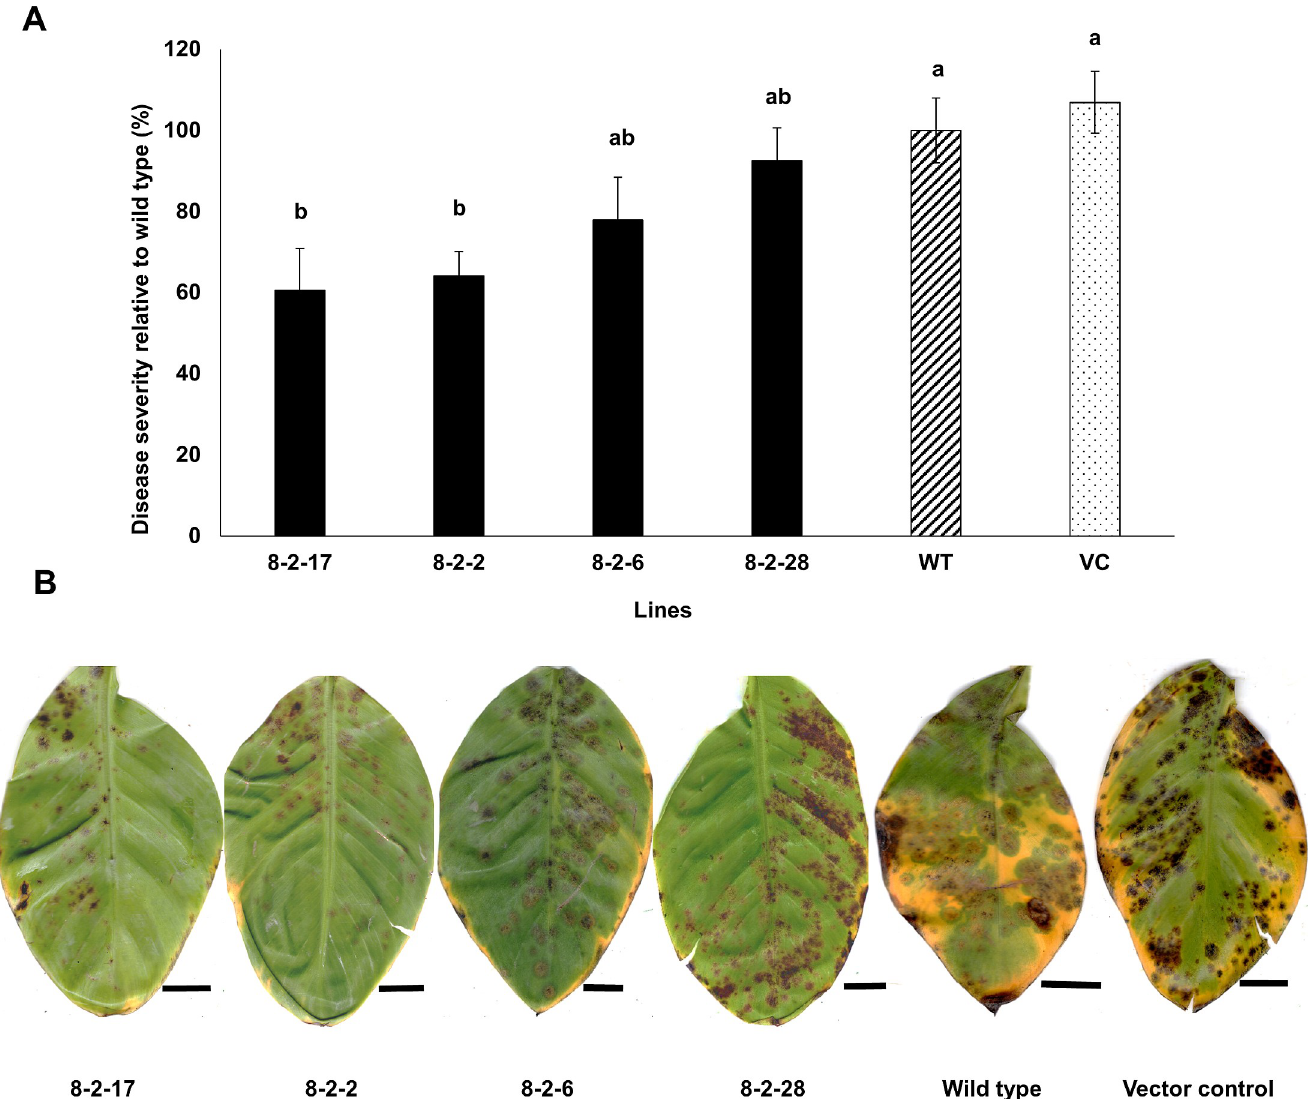
Fig 8. Black Sigatoka disease development in banana inoculated with wild type, vector control, and transformants silenced with the PKS8-2 silencing construct. A) Black Sigatoka disease response as seen in banana plants 9 weeks after inoculation with the wild type (hatched bar), vector control (dotted bar) and silencing transformants (dark bars). Disease severity caused by each isolate was assessed by the Fiji ImageJ program and is shown relative to wild type isolate 10CR1-24. Data shown are results of two independent experiments with 8 plants per strain in each experiment. The within-group differences between the different PKS8-2 silencing transformants, vector control, and wild type isolate were examined using ANOVA with Bonferroni post hoc test for multiple comparisons. Bars represent Mean ± SE. Different letters on bars indicate statistically significant differences ( p � 0.05). B) Symptoms on banana plants inoculated with PKS8-2 silencing transformants 8-2-17, 8-2-2, 8-2-6, and 8-2-28 as compared to symptoms on banana inoculated with the vector control and wild type isolate 10CR1-24. Scale bar represents 1 inch. https://doi.org/10.1371/journal.pone.0258981.g008 (S2 Table). However, this gene resides on a different genome assembly scaffold than the rest of the gene cluster. As the P . musae gene cluster is located at the end of a scaffold, and this cyto- chrome P450 gene is at the end of another scaffold (S5 Table), more complete genome assem- bly data would be needed to confirm if these are part of the same gene cluster. Additionally, the predicted P . fuligena NRPS gene was predicted to be much shorter (approximately 1.8 kb) than the NRPS genes from P . fijiensis (8.1 kb), P . musae (10 kb), P . eumusae (8.5 kb), and P . cruenta (8.1 kb) (S3 Table). Based on domain analysis using the PKS/NRPS Analysis Web-site